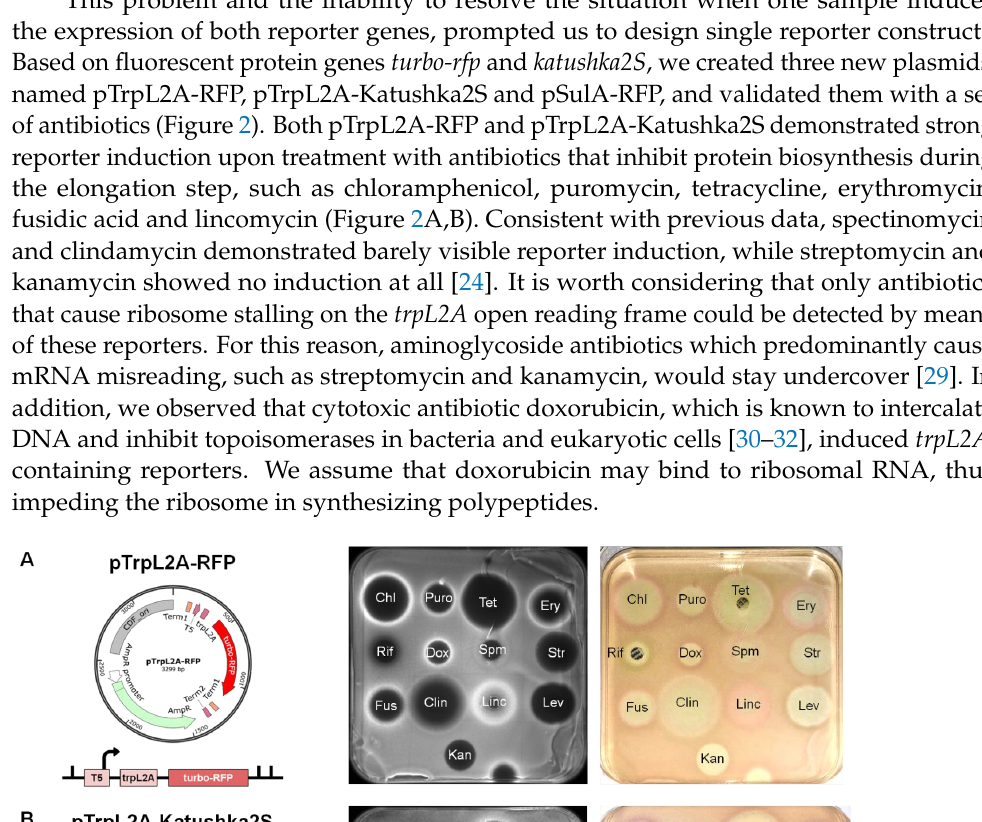
E. coli Δ tolC strain transformed with the pDualrep2 plasmid. As a result, we observed that